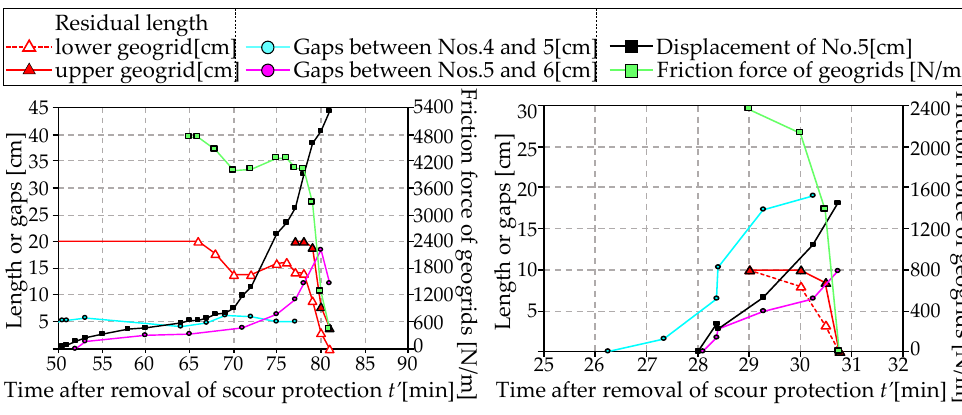
Figure 11. Time series of the residual length of the geogrid in the panel (No. 5), displacement of the panel (No. 5), the gaps between the concrete panels (Nos. 4–5 and Nos. 5–6), and the friction force of the geogrid: ( a ) Case C with L = 20 cm; ( b ) Case D with L = 10 cm. From the perspective of the friction force of the geogrid, in Case C ( L = 20 cm) the friction force was 4732 N/m at the beginning of the experiment but these values were gradually reduced to about 4000 N/m when the lower geogrid started to be eroded. Friction force had been maintained at approximately 4000 N/m. As erosion of the levee body expanded to the upper geogrid, the frictional force of the geogrid decreased sharply. In Case D ( L = 10 cm), the initial friction force was 2400 kN/m, but with the displacement of the concrete panel, the levee body was also eroded, and the friction force of the geogrid decreased sharply. The gravity of the laminar drainage layer and the concrete panel was 603 N/m, so fluid force, larger than gravity, acted on the concrete panel. As a result, it is